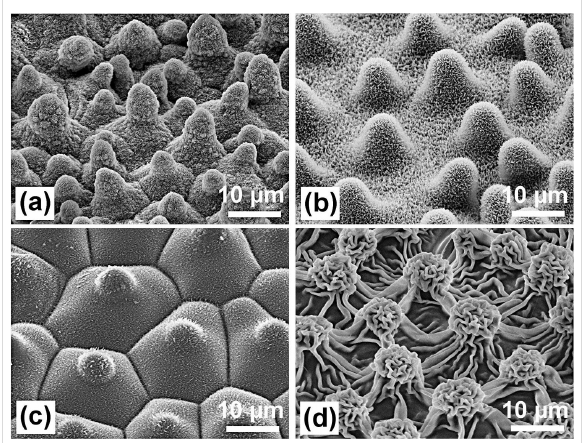
Figure 3: SEM images of the papillose leaf surfaces of Nelumbo nucifera (Lotus) (a), Euphorbia myrsinites (b), Colocasia esculenta (c), and Alocasia macrorrhiza (d). Lotus has the highest density of papillae with varying heights and the smallest diameter of the papillae. The papillae of the other species have larger diameters and are covered with different wax types: wax platelets (E. myrsinites and C. esculenta ) and a wax film ( A. macrorrhiza) which covers cuticular